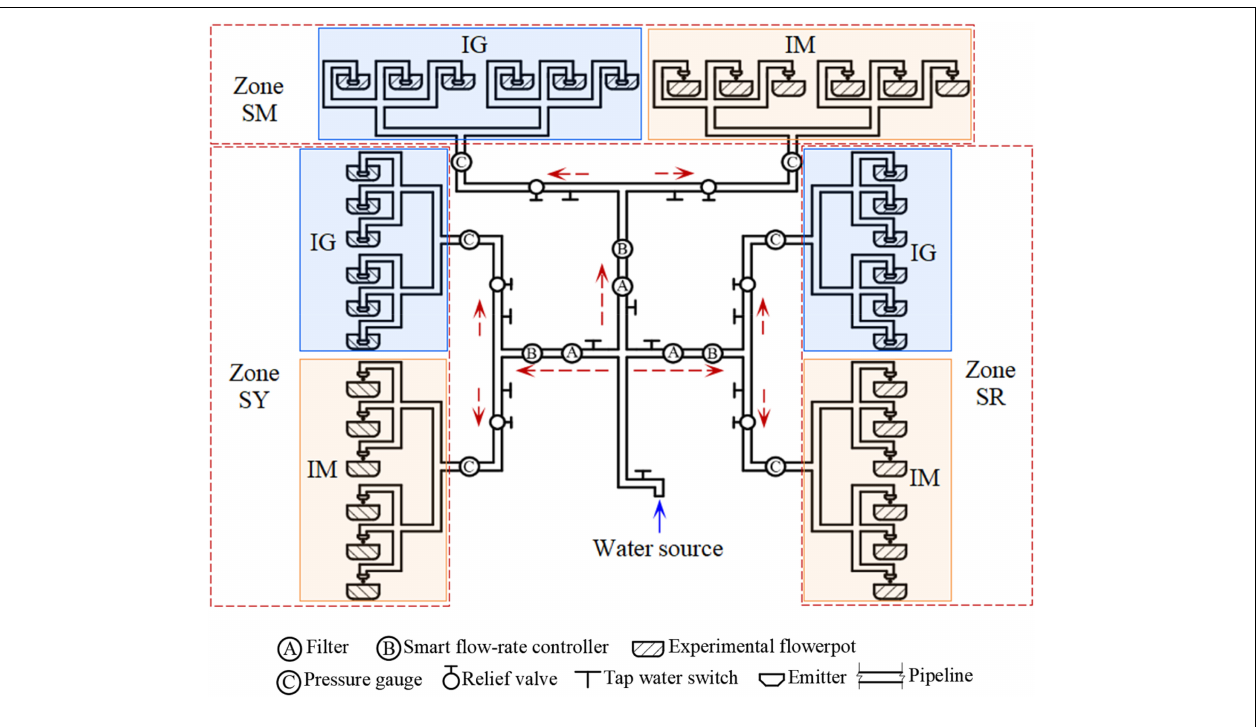
FIGURE 2 | Schematic of WUET experimental